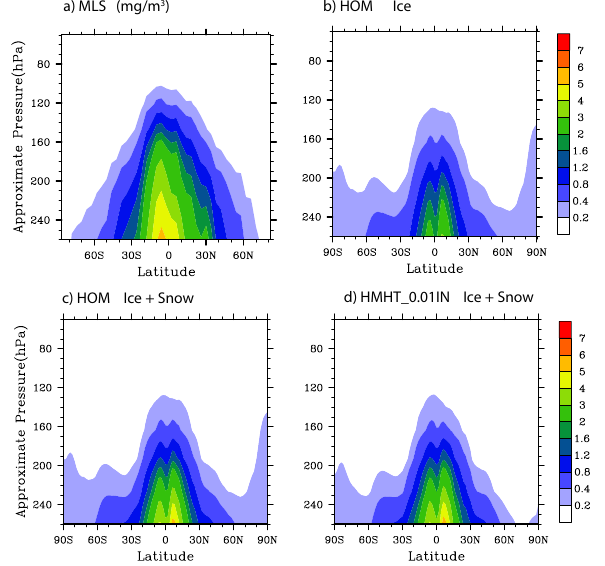
Fig. 3. Annual average zonal mean (a) grid-averaged ice wa- Figure 03 ter content that measured by the Aura MLS instrument, (b) grid- averaged ice water content in HOM, (c) grid-averaged ice water content+snow water content in HOM and (d) grid-averaged ice wa- ter content+snow water content in HMHT 0.01IN (mg/m 3 ).